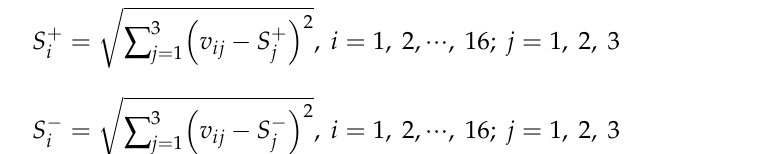
Table 4. The positive and negative ideal solutions S + experimental result to the optimal ideal solution C ∗ found that the C ∗ value of experiment No. 15 ranks the highest. This indicated that the i process parameters of experiment No. 15 (f = 700 Hz, c = 240 µ F, v = 150 mm/min) were